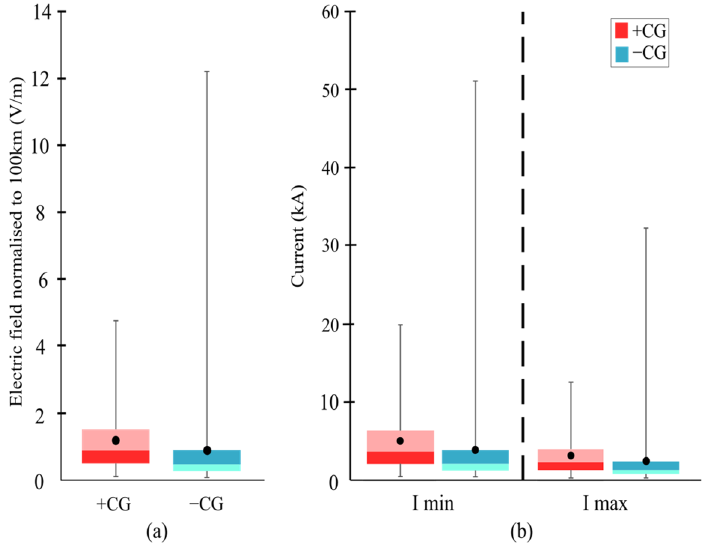
Figure 6. ( a ) Electric field intensity normalized to 100 km for +CG (red box) and − CG (cyan/blue box); ( b ) estimated positive and negative CG minimum and maximum peak currents.